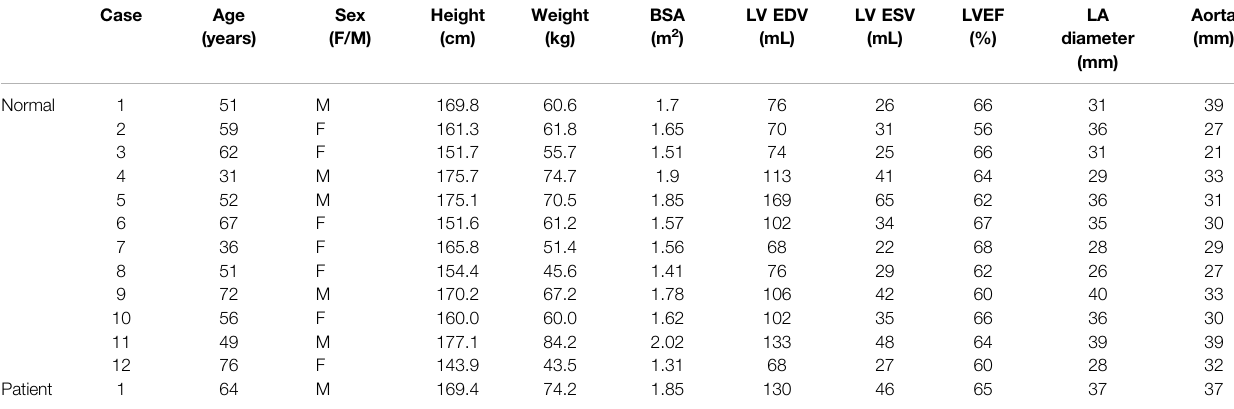
TABLE 1 | Demographic characteristics of the in-vivo subjects. Case